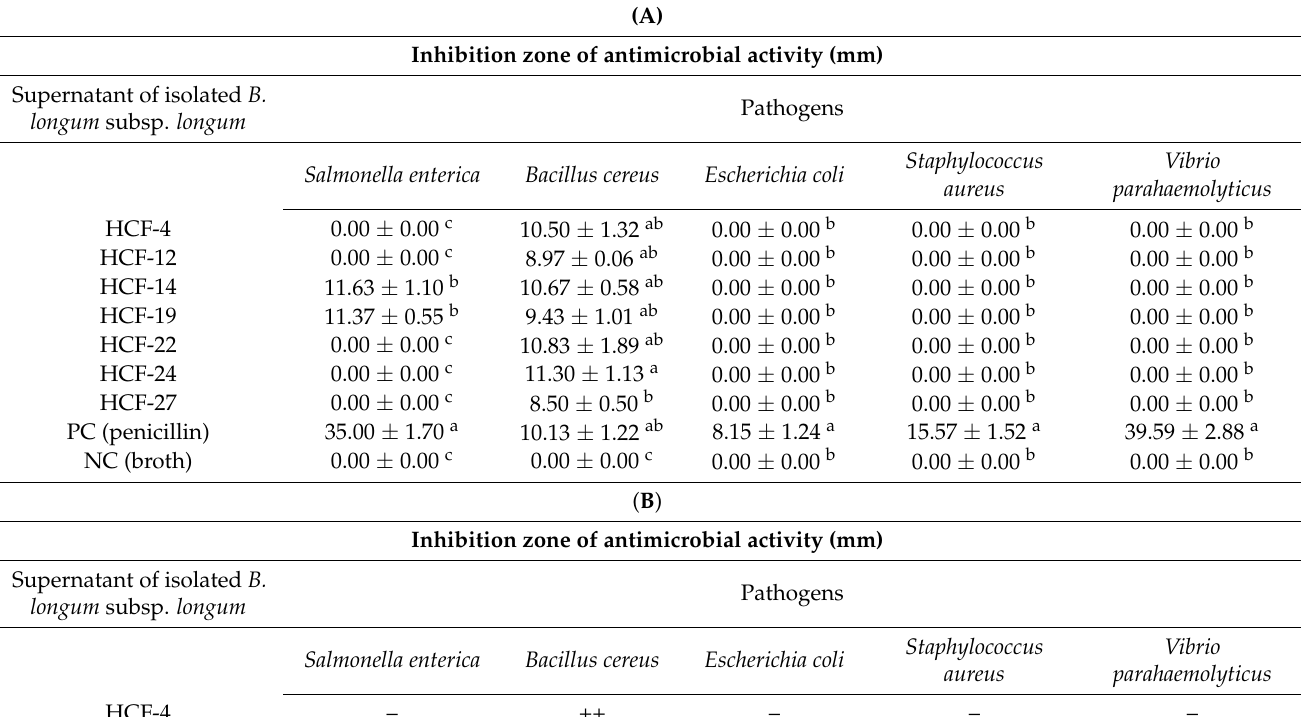
Table 3. The antimicrobial inhibition zone of (A) the supernatant from each isolated microorganism strain and (B) antimicrobial activities against different pathogens. (A) Inhibition zone of antimicrobial activity